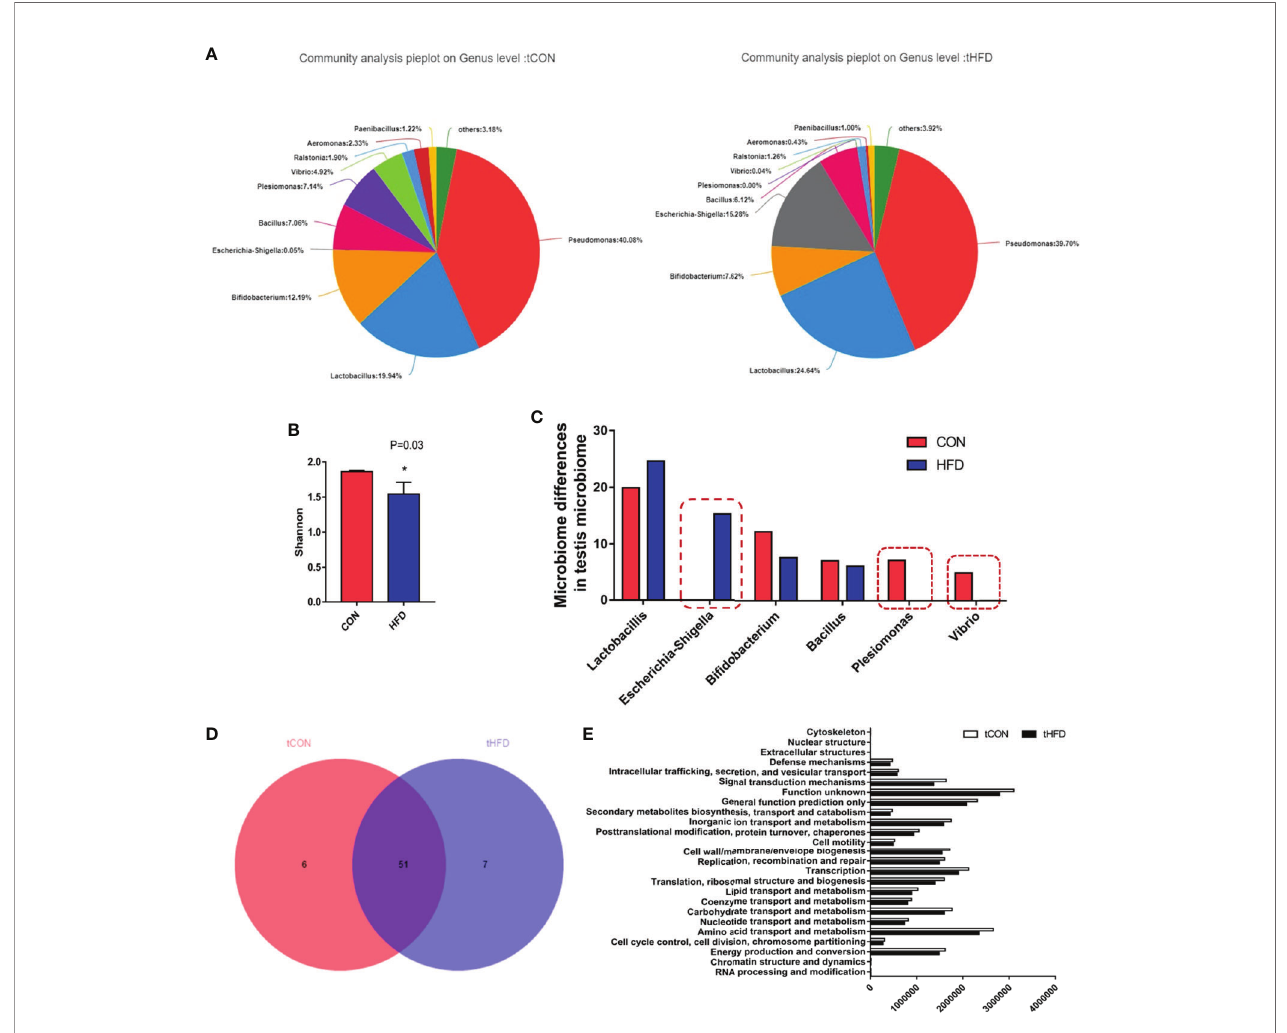
FIGURE 5 | Microbial community composition analysis in the testes of normal and obese male zebra fi sh showing marked microbial differences between the two groups. (A) The pie chart shows the community species composition information of testicular microbes at the gate level in the control and HFD groups. (B) Shannon diagram of alpha diversity analysis of testicular microorganisms ( P = 0.03). (C) Analysis and selection of dominant strains of testicular microbial communities that were markedly differently expressed in the two groups. (D) Venn plot population analysis results between the two groups. (E) Predictive analysis of microbiota function. Data represent mean ± SME ( n = 3). * at P <